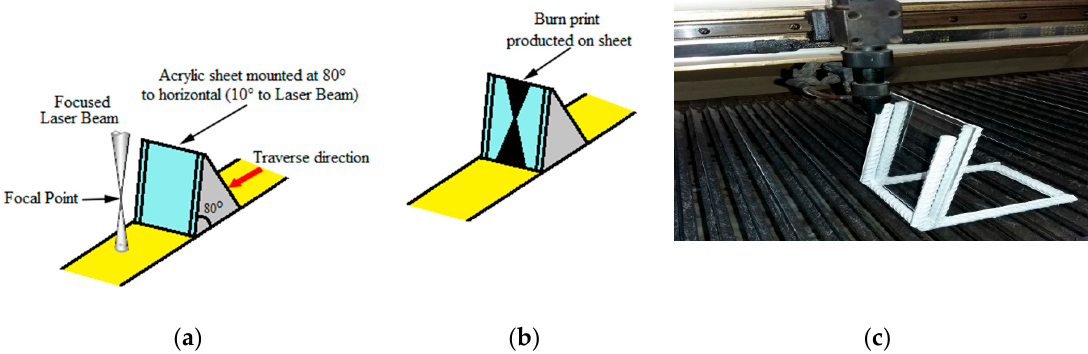
Figure 4. Determination of the laser beam focal point: ( a ) before passing through laser, ( b ) effect of the laser beam on the acrylic sheet that identifies the location of the focal point, ( c ) FPP determining with the CO 2 laser.